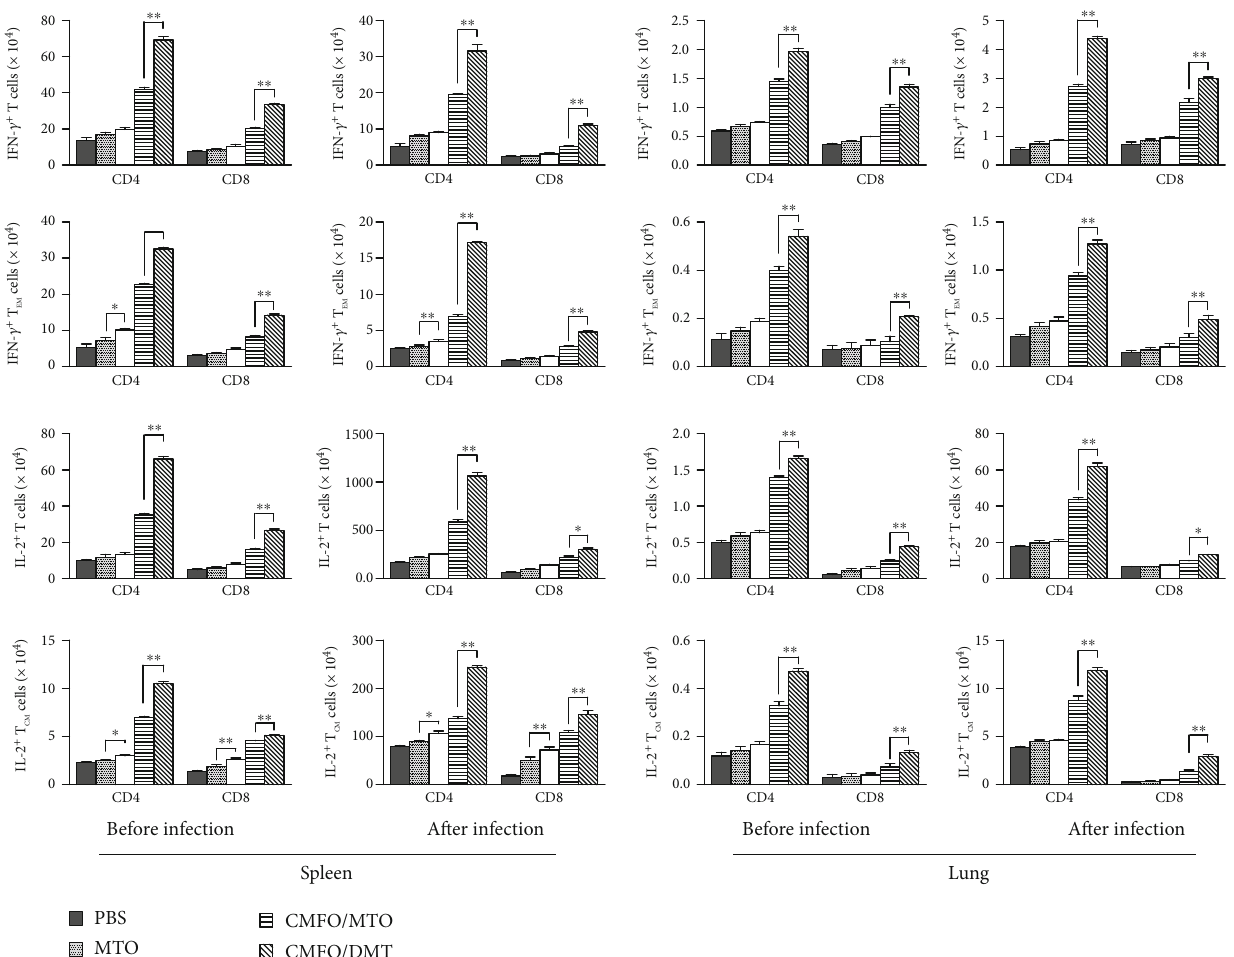
Figure 3: CMFO-speci fi c T cells in the spleen and lung of di ff erent vaccinated mice before and after exposure ( n = 6 ). 10 weeks after vaccination and 4 weeks postchallenge, splenocytes and lung cells were prepared from each mice and counted, respectively. The absolute numbers of CMFO-speci fi c IFN- γ + or IL-2 + CD4 + and CD8 + T cells, or T and per lung were identi fi ed by intracellular cytokine staining and a multicolor fl ow cytometer. The results were shown as the mean ± SEM . ∗ p < 0 : 05 and ∗∗ p < 0 : 001